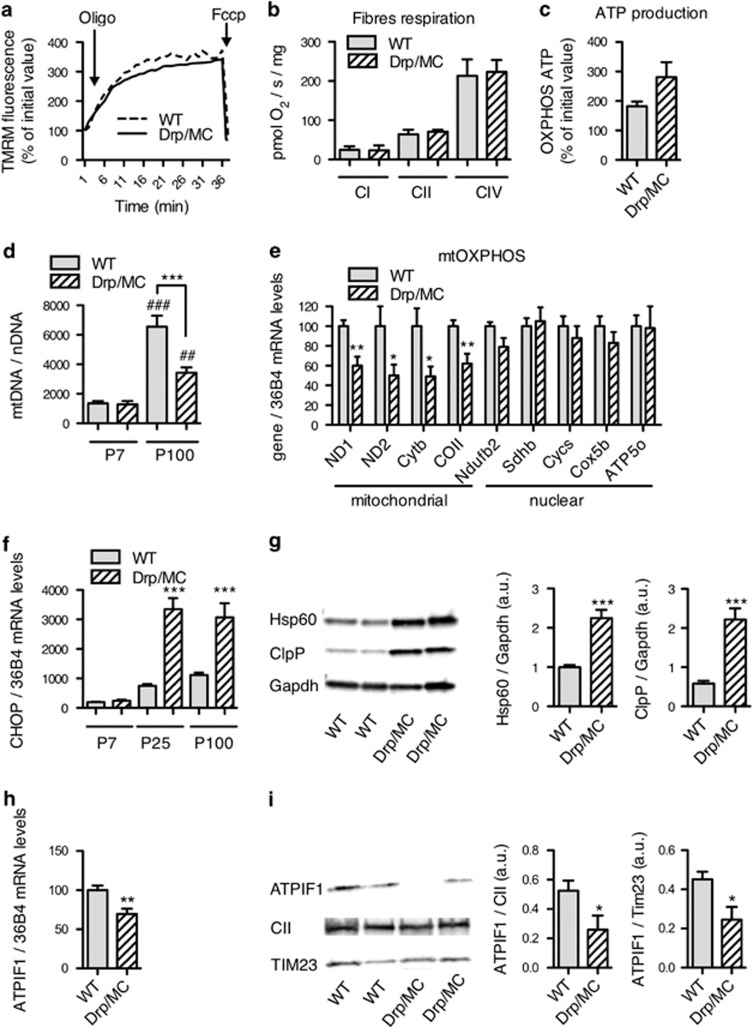
Mitochondrial bioenergetics remained unchanged but mtDNA content is reduced and a mtUPR response is activated in Drp/MC muscle. (a) Fibres were loaded with the mitochondrial potentiometric dye TMRM (25 nM) and the fluorescence was recorded for 40 min. The arrows indicate the time of addition of oligomycin (Oligo; 5 μM) and FCCP (4 μM). (b) Mitochondrial respiration in permeabilised TA myofibres was measured by using high-sensitivity respirometer (n=8 animals per genotype); complex I (CI), complex II (CII) and complex IV (CIV). (c) Isolated mitochondria from TA muscle were incubated with luciferin-luciferase and the ATP generated through oxidative phosphorylation was measured (n=9 animals per genotype). (d) Mitochondrial DNA (mtDNA) content in TA muscle from P7 and P100 animals (n=8 per genotype). (e) RT-qPCR analysis of mtDNA and nuclear DNA encoded respiratory chain subunits in P100 quadriceps muscle. (f) RT-qPCR analysis of Chop mRNA levels in quadriceps from P7, P25 and P100 WT and Drp/MC mice (n=8 per genotype). (g) Western blot analysis of Hsp60 and ClpP protein expression levels in quadriceps from adult WT and Drp/MC mice (n=8 per genotype). Actin was used as control. (h) RT-qPCR analysis of Atpif1 mRNA levels in quadriceps from P100 WT and Drp/MC mice (n=8 per genotype). (i) Western blot analysis of ATPIF1 protein expression levels in quadriceps from adult WT and Drp/MC mice (n=8 per genotype). Tim23 and Complex II (CII) were used as control. Error bars represent S.E.M. *P<0.05, **P<0.01, ***P<0.001 versus WT; ##P<0.01, ###P<0.001 versus P7 mice